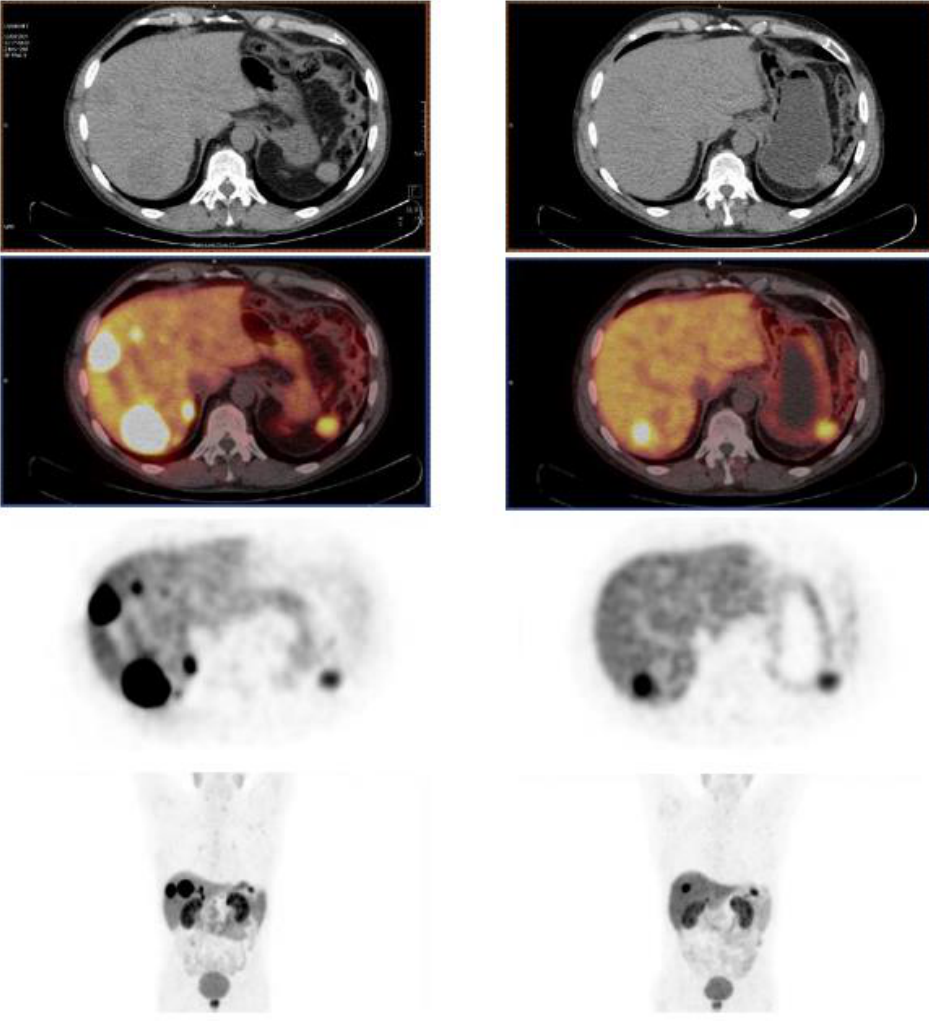
Figure 11. [ 68 Ga]Ga–DOTATATE PET/CT in the patient described by Budlewski et al. [227], showing important uptake in hepatic NET metastases after treatment with a long-acting somatostatin analog plus everolimus ( left ), and significant decrease in lesion uptake after two cycles of [ 225 Ac]Ac–DOTATATE associated with good metabolic and structural response ( right ).